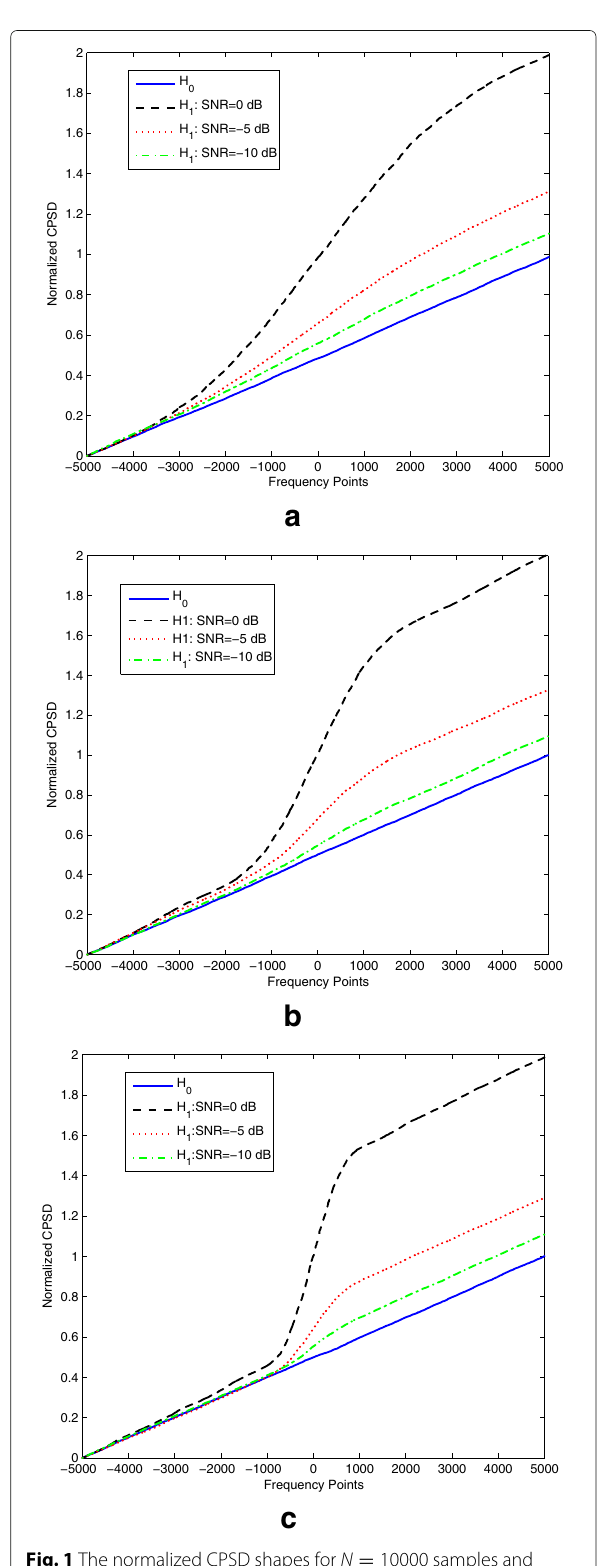
Fig. 1 The normalized CPSD shapes for N = 10000 samples and several values of N s and SNR: rectangular pulse-shaping filter. a N s = 2 sps. b N s = 4 sps. c N s = 8